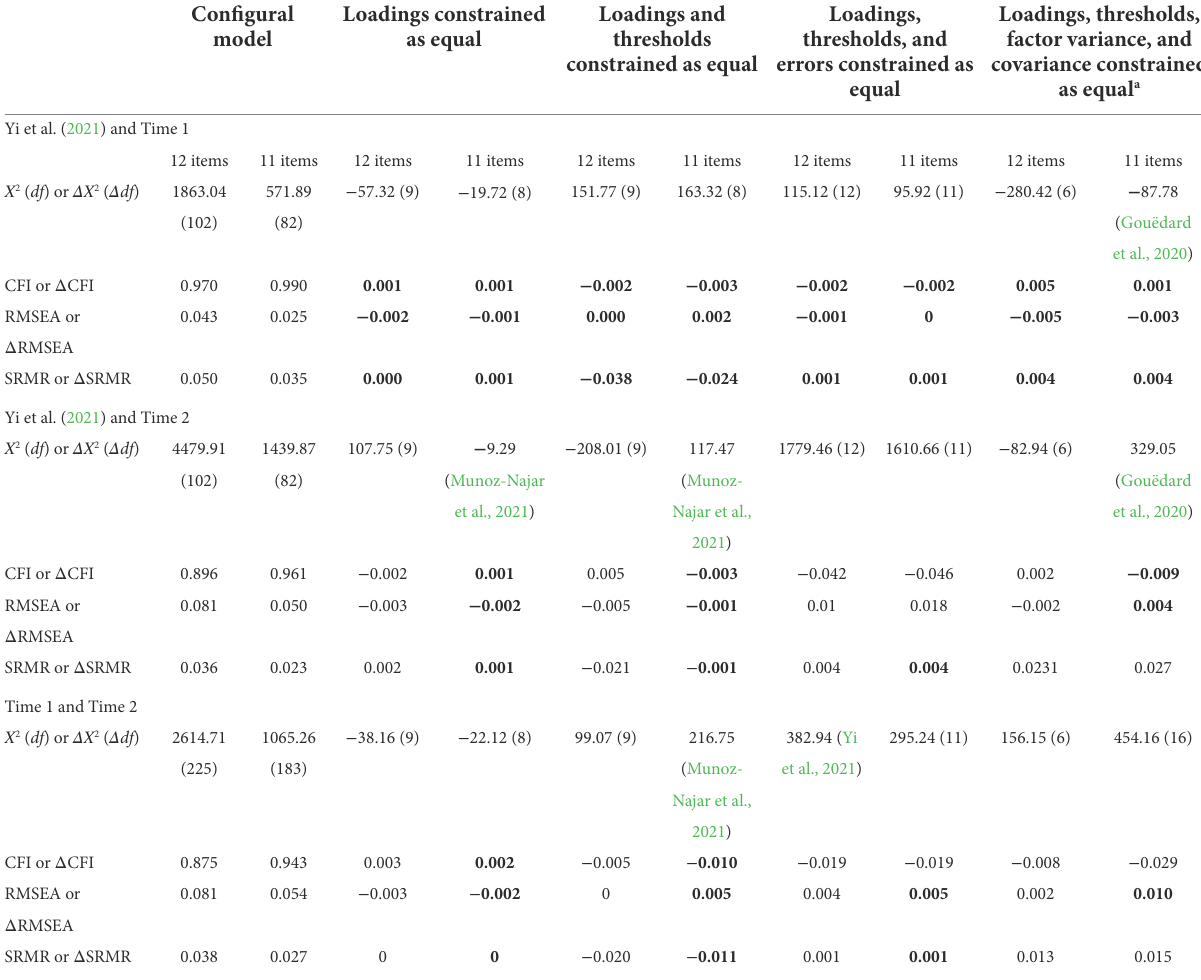
TABLE 4 Tests of measurement